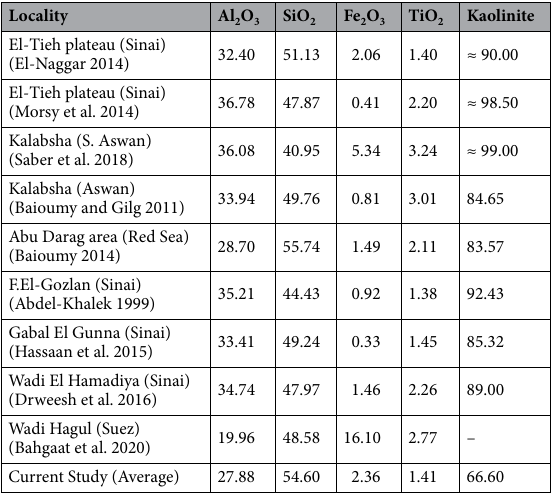
Table 5. Comparison of the main chemical (wt%) and mineralogical (wt%) composition of the investigated kaolin and varied kaolins in different localities from Egypt from